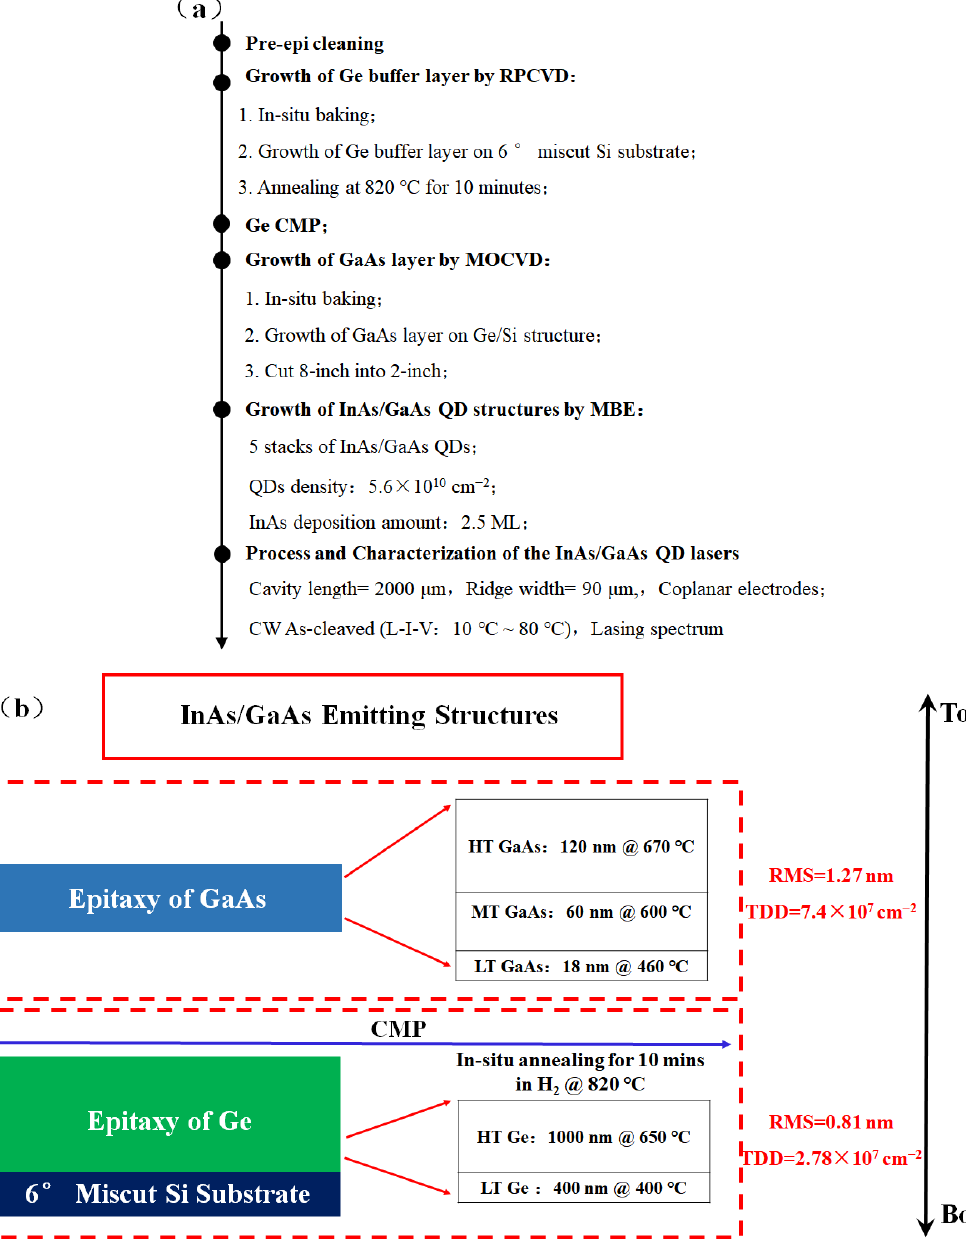
Figure 1. Depiction of the integration of InAs/GaAs QD lasers on Si: ( a ) process flow and ( b ) schematic of the film structure.